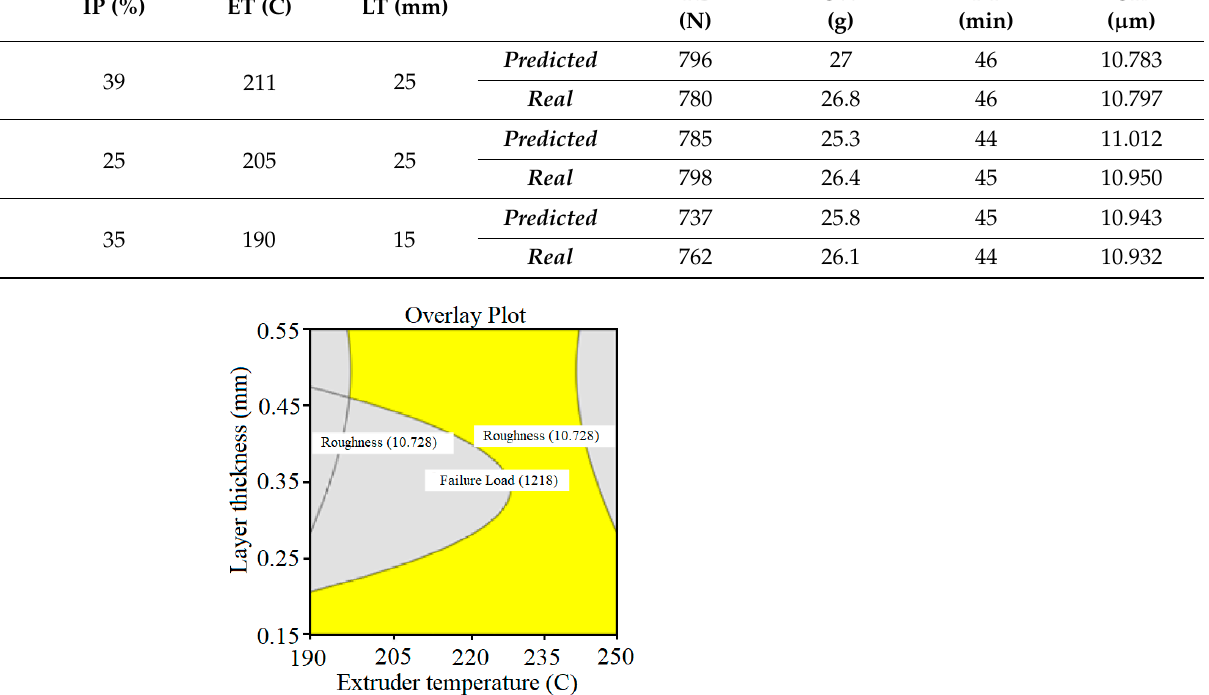
Table 9. Predicted and real parameters for optimum samples.